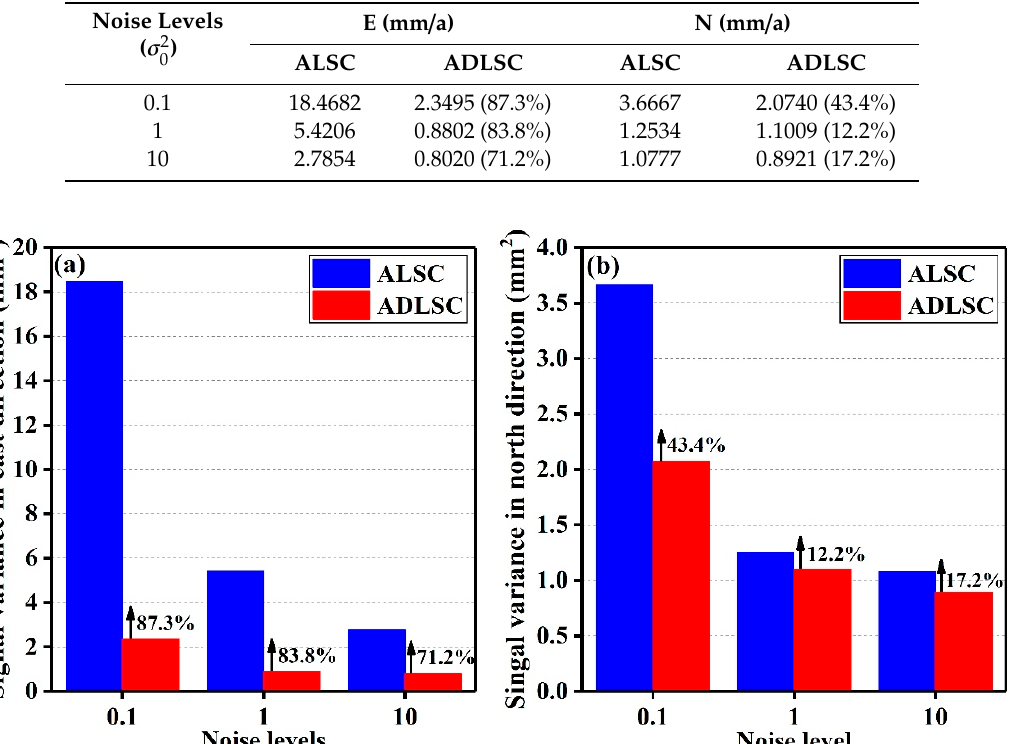
Figure 9. Comparison of the iteration times and fitting RMS in the iterative process of the VCEM calculation: ( a ) east direction; ( b ) north